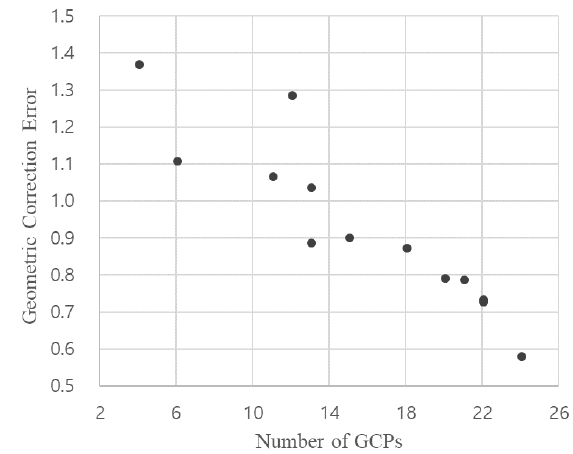
Figure 4. Relationship between number of GCPs and geometric correction